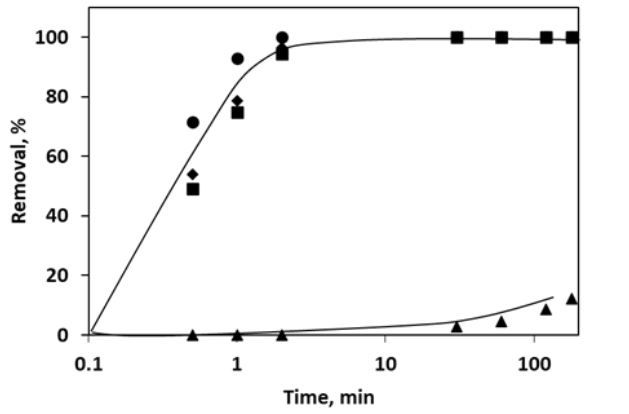
Figure Figure 3. Pollutant removal using SW: ▲ — caffeine; ■ — imidacloprid; ●— clothianidin; ♦ — thia- methoxam.